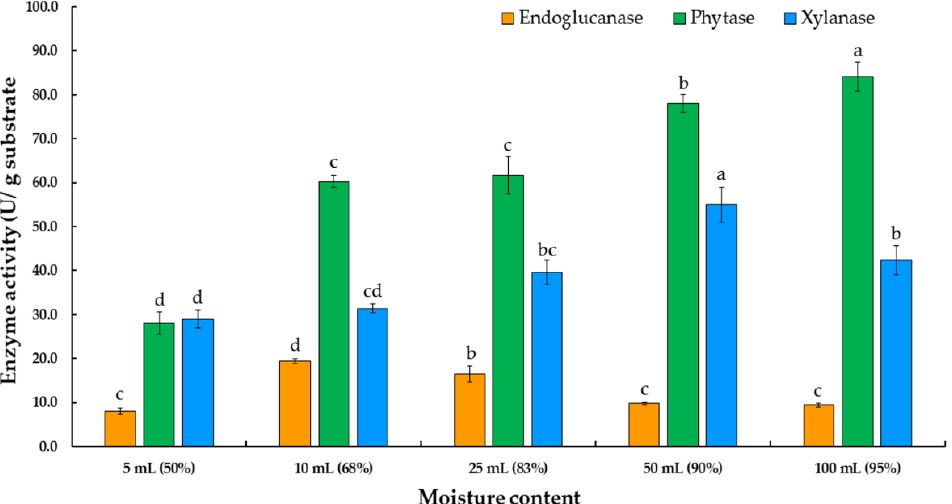
Figure 6. Phytase, endoglucanase, and xylanase production by Thermoascus aurantiacus SL16W at various moisture contents under semi-solid state fermentation. Average ± standard deviation from three replicate experiments. Different letters in the same column are considered significantly different according to Duncan’s multiple comparison test ( p ˂ 0.05).